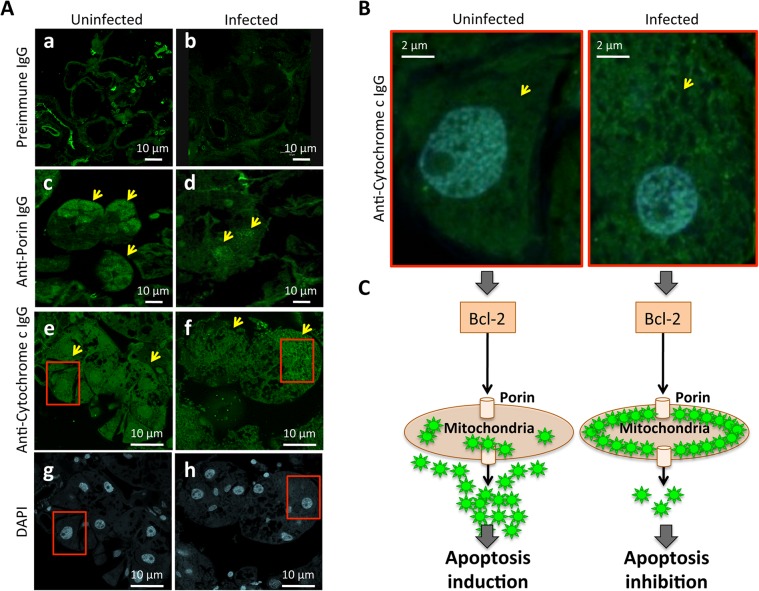
Immunohistochemical localization of tick Porin and Cytochrome c.The results showed that Porin levels were lower in infected than in uninfected tick salivary glands but demonstrated that differences in Cytochrome c levels were not at the protein level but in the localization of Cytochrome c, which was distributed in the cell cytoplasm of uninfected tick salivary glands but was mainly localized within organelles that probably corresponded to mitochondria in A. phagocytophilum-infected tick salivary glands. (A) Representative images of immunofluorescence analysis of uninfected and A. phagocytophilum-infected adult female tick salivary glands. Tick tissues were stained with rabbit anti-tick proteins antibodies (green, FITC). Arrows show positive staining in response to anti-Porin and anti-Cytochrome c IgG not present after incubation with preimmune IgG. (a-b) preimmune control serum-treated cells, which gave similar results between uninfected and infected ticks. (c-d) uninfected and infected cells stained with anti-Porin antibodies. (e-f) uninfected and infected cells stained with anti-Cytochrome c antibodies. (g-h) uninfected and infected cells stained with DAPI. Bars, 10 μm. (B) Sections in the red squares in e-h were magnified 5X and superimposed to illustrate the localization of the Cytochrome c in the cytoplasm of uninfected and infected adult female tick salivary glands. Arrows show positive staining. (C) Model of the Porin-mediated inhibition of Cytochrome c release as the anti-apoptotic mechanism to facilitate bacterial infection of tick salivary glands.